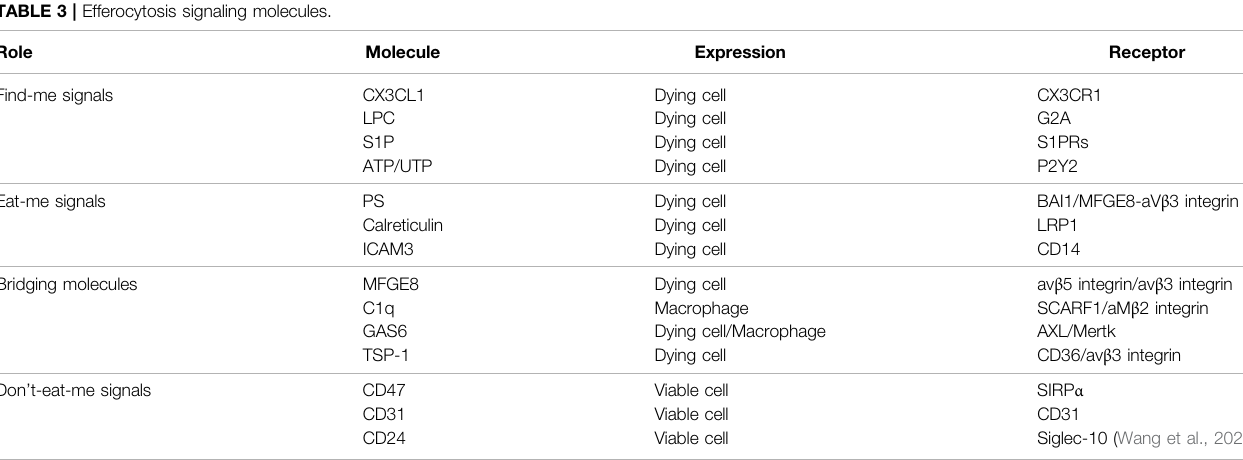
CX3CL1, CX3C chemokine ligand 1; LPC, lysophosphatidylcholine; S1P, Sphingosine-1-phosphate; ATP/UTP, Adenosine Triphosphate/Uridine Triphosphate; CX3CR1, CX3C chemokine receptor 1; G2A, G-protein-coupled receptor; S1PRs, Sphingosine-1 phosphate receptors; P2Y2, Purinergic receptor P2Y2; PS, phosphatidylserine; BAI1, Brain-speci fi c angiogenesis inhibitor 1; MFGE8, Milk fat globule-EGF, factor 8; LRP1, Low-density lipoprotein receptor-related protein 1; C1q, Complement component 1q; GAS6, Growth arrest- speci fi c gene 6 product; TSP-1, Thrombospondin-1; SCARF1, Scavenger receptor F1; AXL, anexelekto receptor tyrosine kinase; Mertk, Mer tyrosine kinase; SIRPa, Signal regulatory protein a; Siglec-10, Sialic acid binding ig like lectin